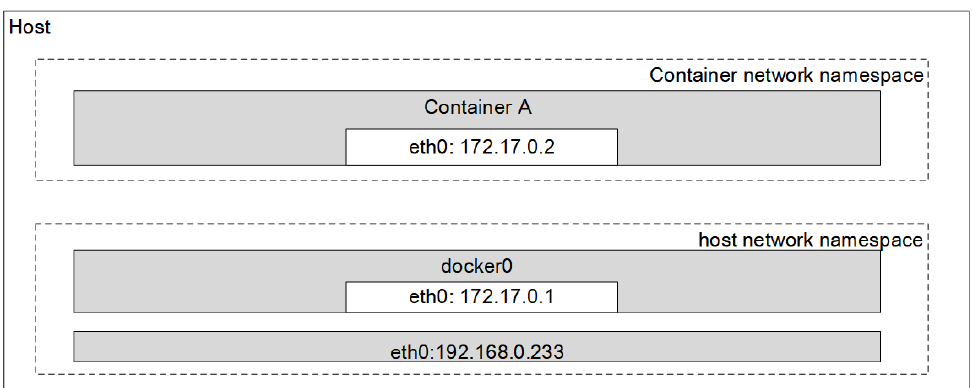
Figure 5. ‘None Mode’ communication method in a single